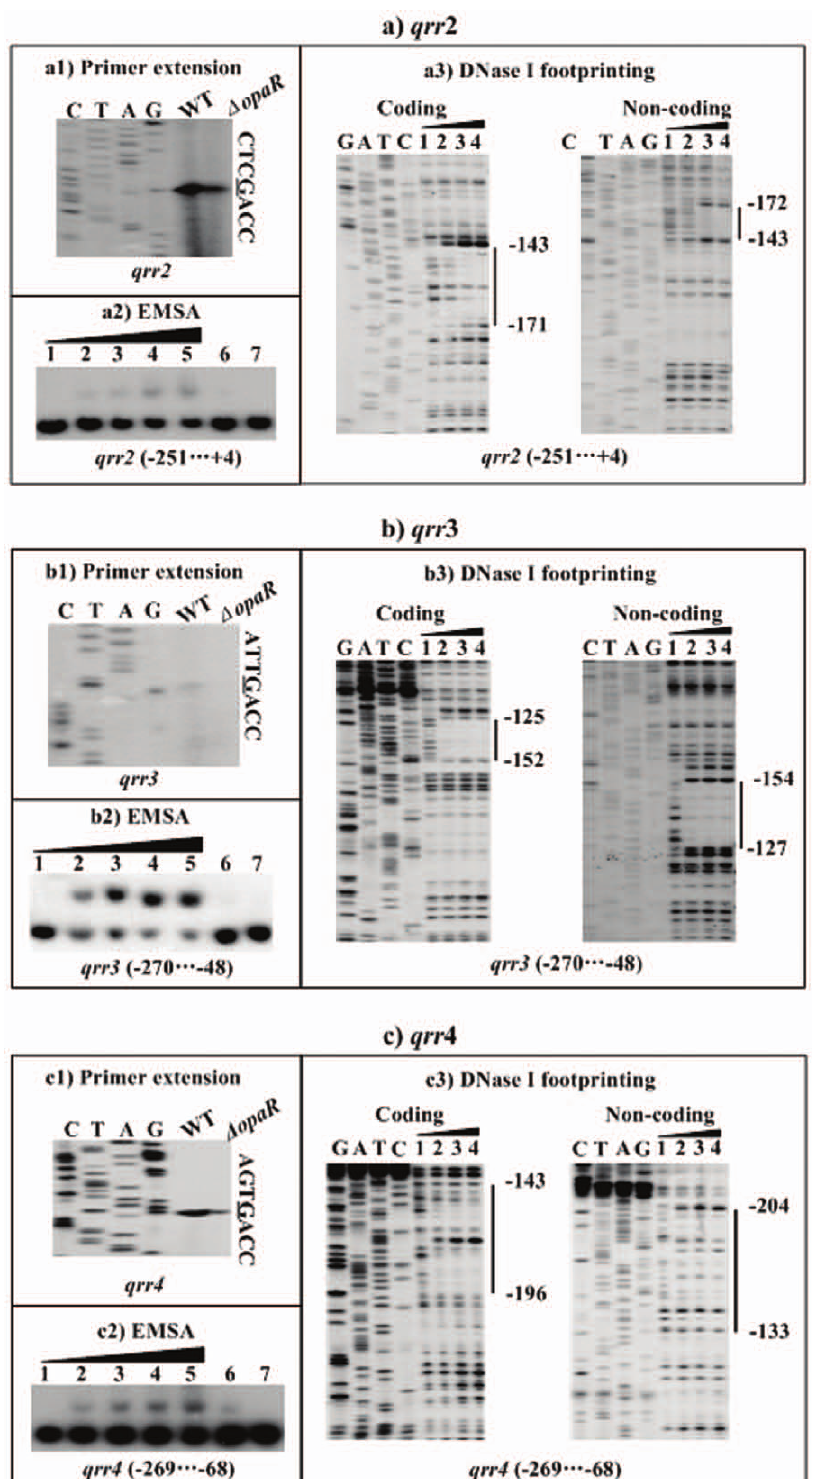
Figure 6. Stimulation qrr2–4 by OpaR. For primer extension (a1, b1, and c1), an oligonucleotide primer was designed to be complementary to the RNA transcript of each of qrr2–4 . For EMSA (a2, b2, and c2) and DNase I footprinting (a3, b3, and c3), the upstream DNA fragments of qrr2–4 were radioactively labeled, and then incubated with increasing amounts of purified His-OpaR protein. The experiments were done as described in Fig. 5. The transcription start sites of qrr2–4 were underlined in the DNA sequence. Lanes G, A, T, and C represented the Sanger sequencing reactions. The footprint regions were indicated with vertical bars. The negative or positive numbers indicated the nucleotide positions upstream or downstream of relevant qr r gene, respectively.